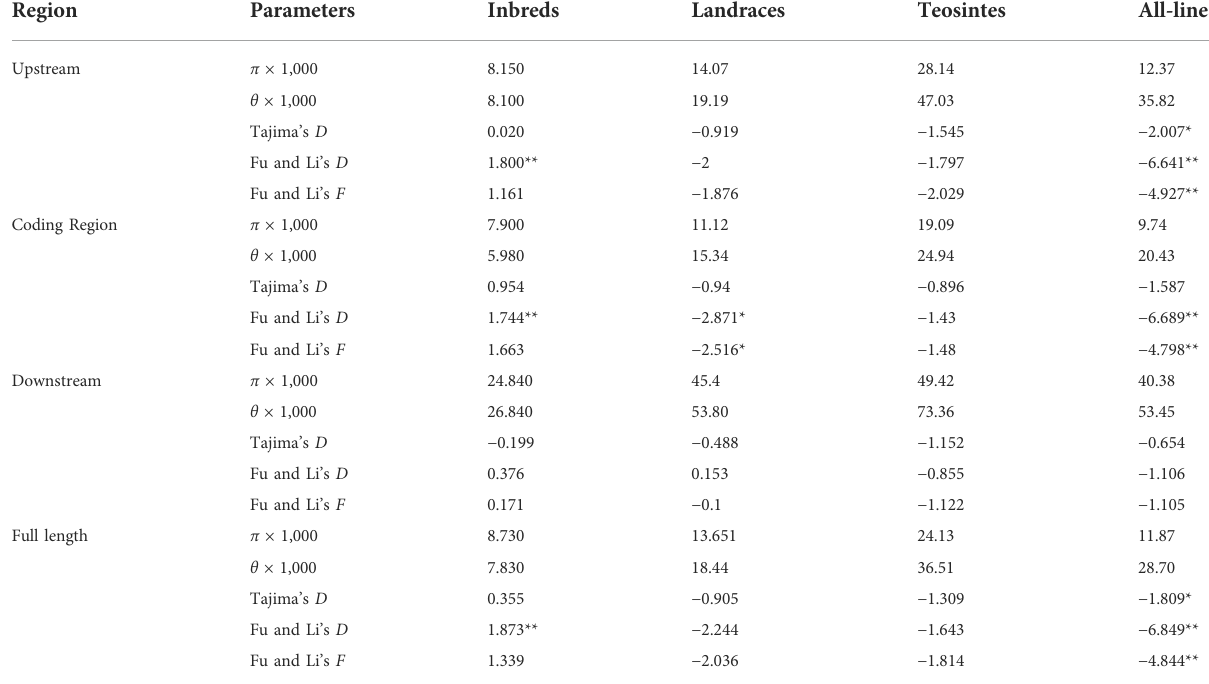
TABLE 2 The estimated parameters of nucleotide diversity, Tajima ’ D , Fu and Li ’ s D , and Fu and Li ’ s F of ZmFWL7 .